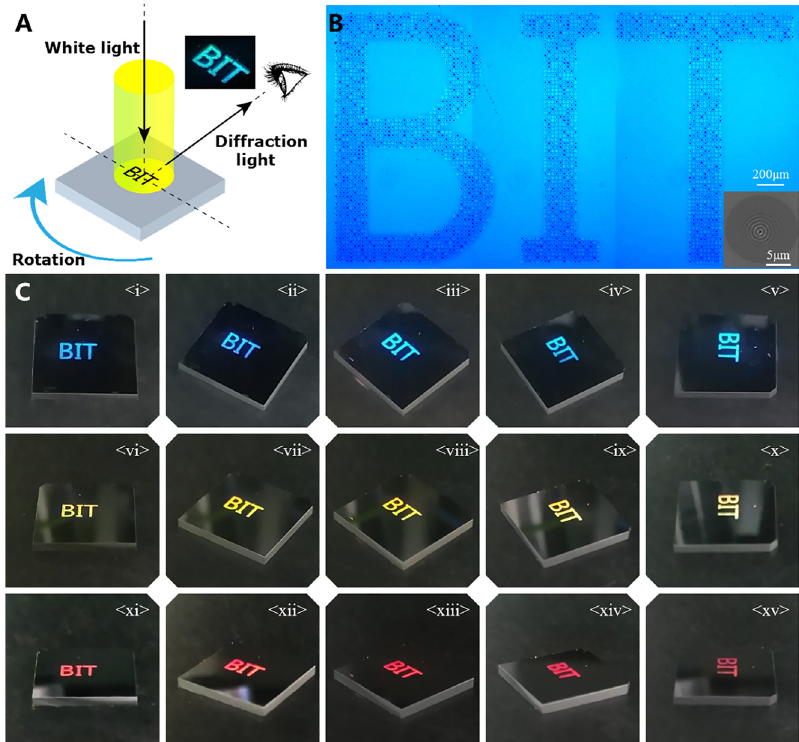
Figure 8: (A) A schematic diagram of generating structural color by vertically irradiating the processing area surface with white light. (B) Optical microscopy image of a large “ BIT ” -shaped area formed by concentric ring structures on a 1 cm × 1 cm silicon wafer and SEM image of a single point. (C) Images of the structural colors at different sample rotation angles and different diffraction